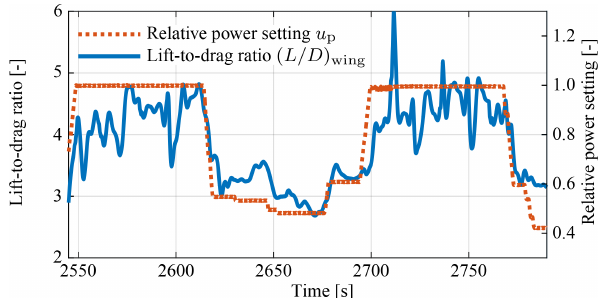
Figure 15. Evolution of the lift-to-drag ratio during pumping cycle